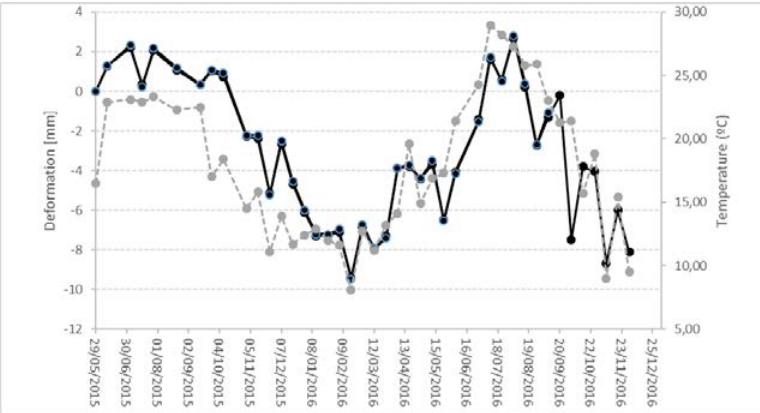
Figure 4. Deformation time series of point 2, whose location is shown in Figure